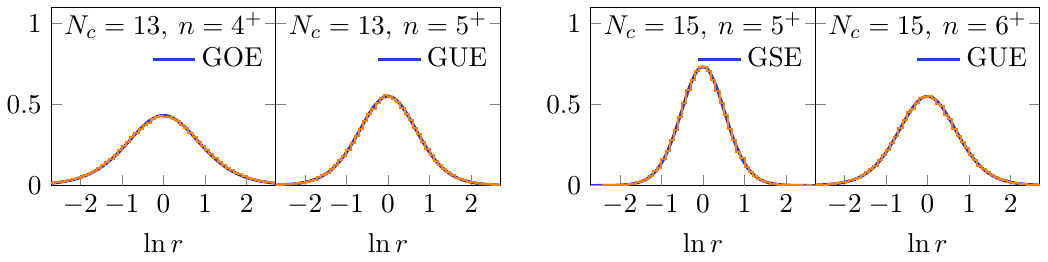
Figure 12 . Same as (cid:12)gure 10 but for ^ q = 5 and compared with the surmises of the RMT classes in table (6.24). The number of realizations used for averaging is 10 3 for N c = 13 and 10 2 for N c =